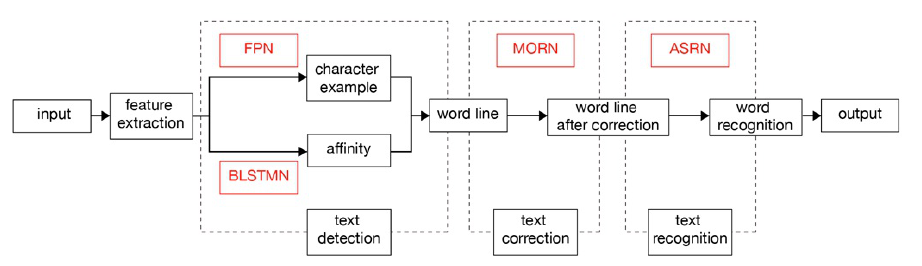
Fig. 7 The overall framework of text recognition